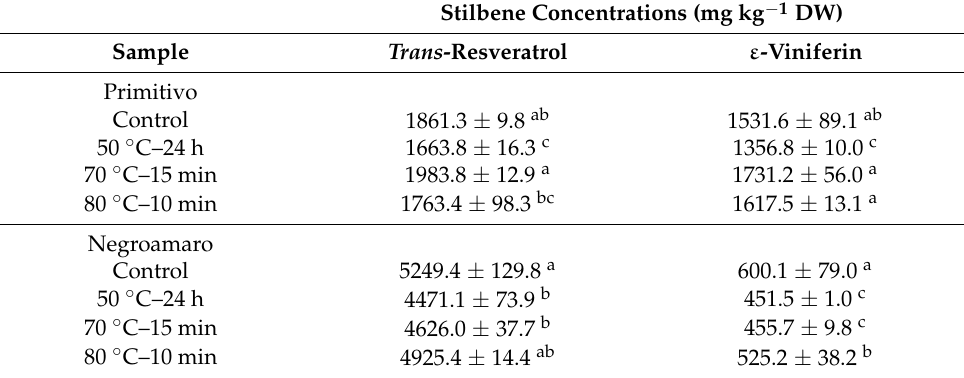
Table 3. The stilbene concentrations in Primitivo and Negramaro vine shoot extracts. The means and standard deviation ( n = 2) are represented in the same column and different letters for each variety indicate significant differences ( p <